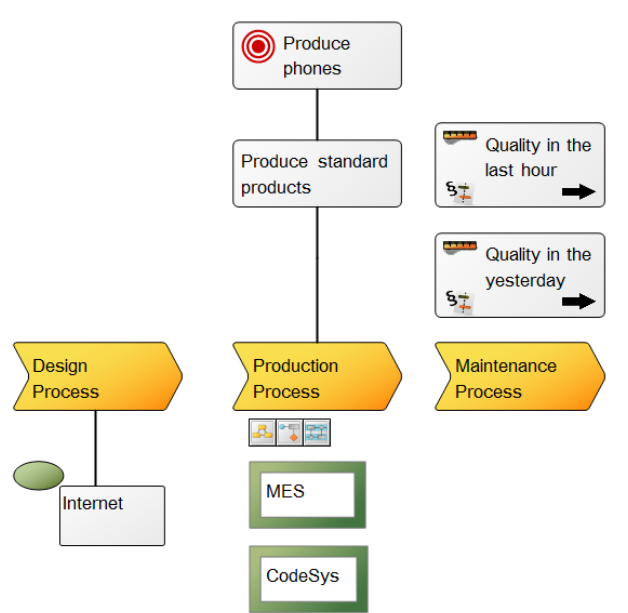
Figure 6. Business layer